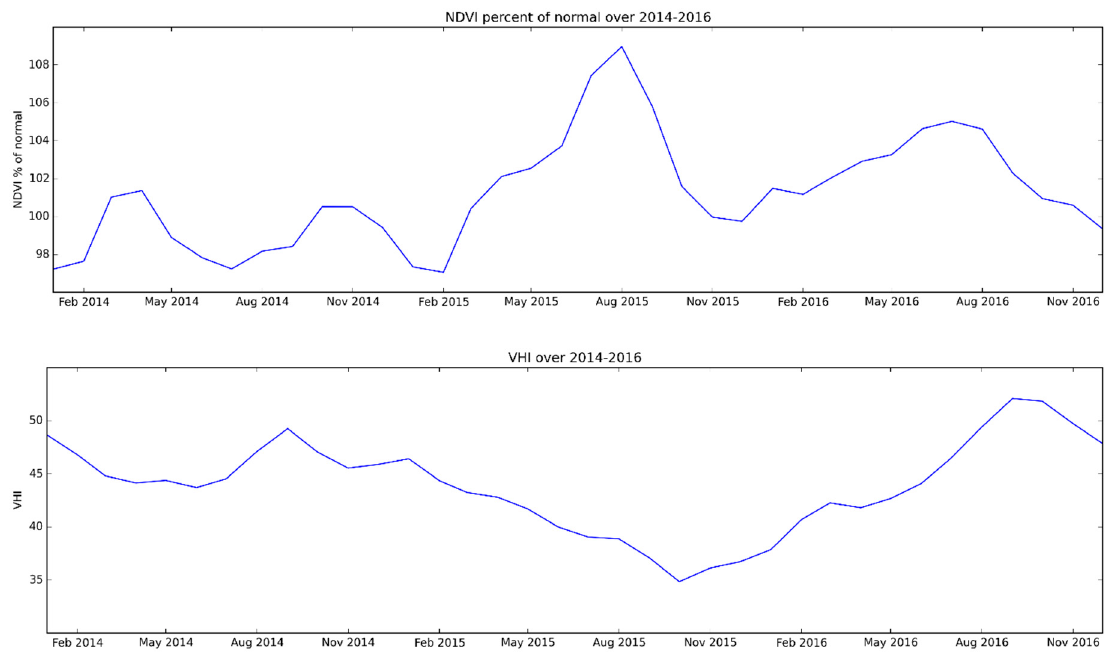
Figure 13. Change in SPI, normalised NDVI anomaly and VHI from 2014 to 2016.